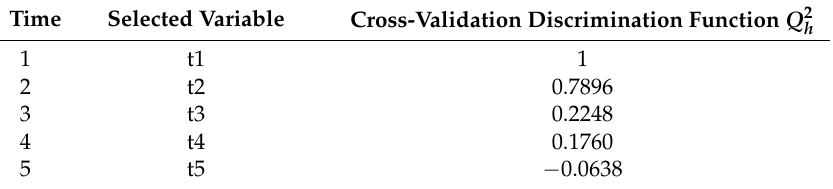
Table 1. The feature screening process.